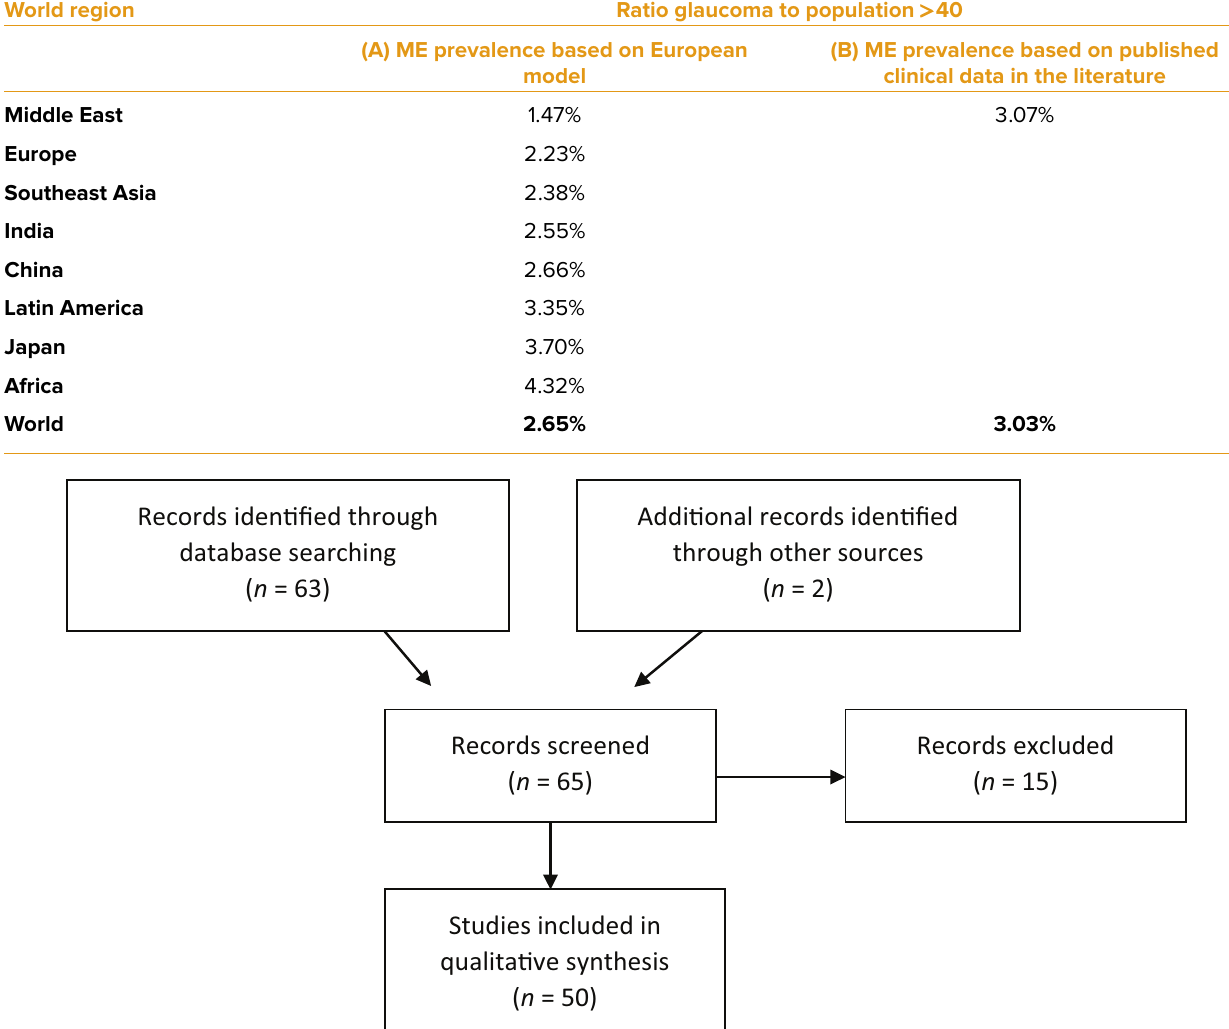
Table 1. Current worldwide estimates of primary open-angle glaucoma including: (A) Middle Eastern (ME) prevalence which is based on the European model. (B) Revised ME and worldwide prevalence which is based on the clinical studies presented in this study [3]